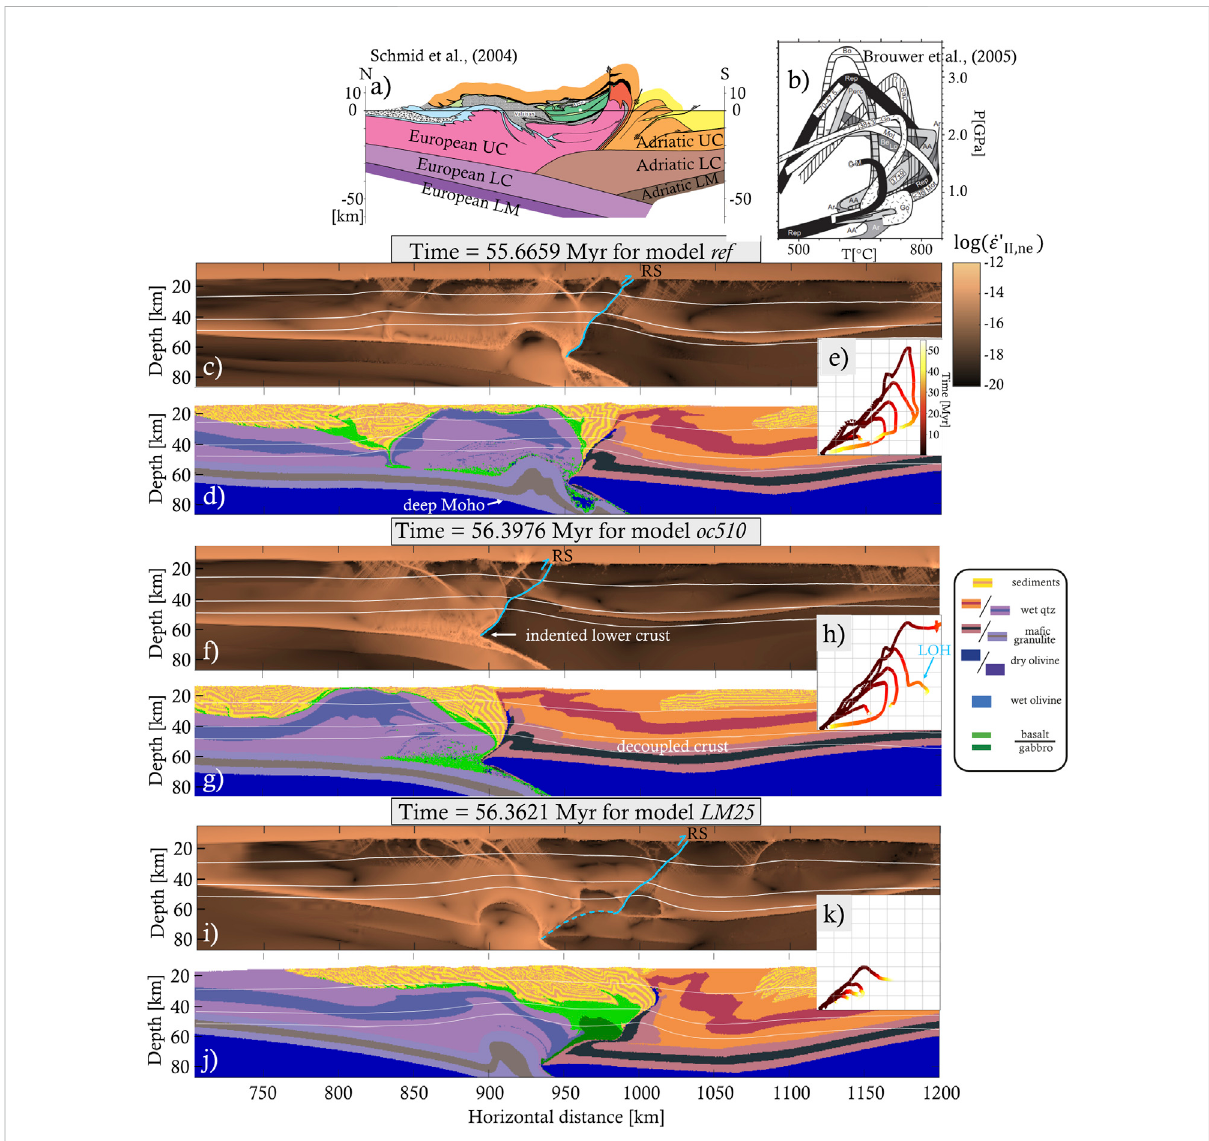
FIGURE 11 Comparison ofacross-sectionthroughtheCentralAlps (A) ,modi fi edfromSchmidetal.(2004a),withcompositionandvisco-plastic strainrate fi eldsofmodels (C,D) ref , (F,G) oc510 and (I,J) LM25 (Table2)at t ~56 Myr.MiniaturePTtpathsareshownforthemodels( E,H,K ,seeFigure4)andfor the Central Alps ( (B) modi fi ed from Brouwer et al. (2005)). The trace of the retroshear (RS) is indicated in each